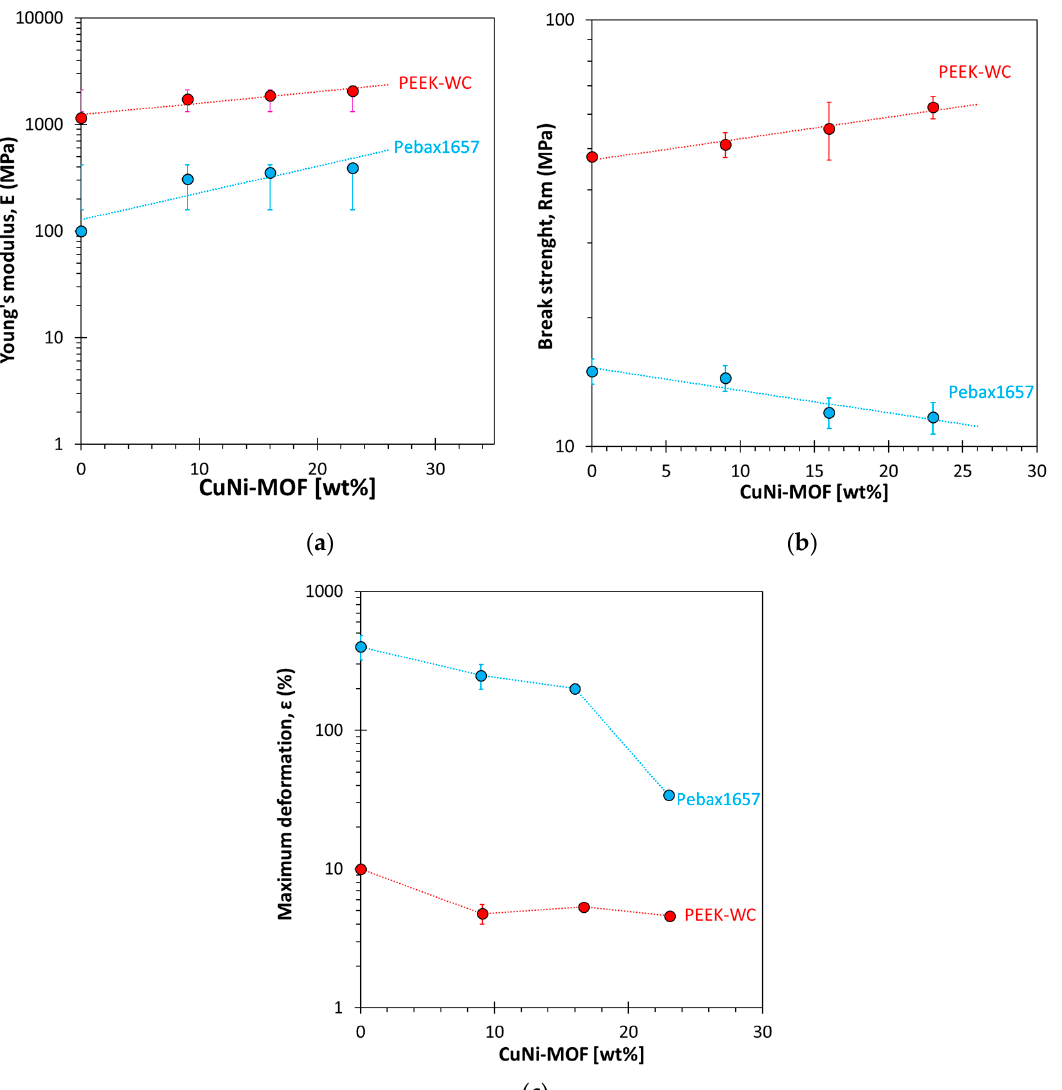
Figure 3. Young’s modulus ( a ), tensile strength ( b ) and maximum deformation ( c ) as a function of the CuNi-MOF concentration in Pebax ® 1657 and PEEK-WC. Values of the neat PEEK-WC [50] and Pebax [51] samples from the literature. Trend lines are given as a guide to the eye.